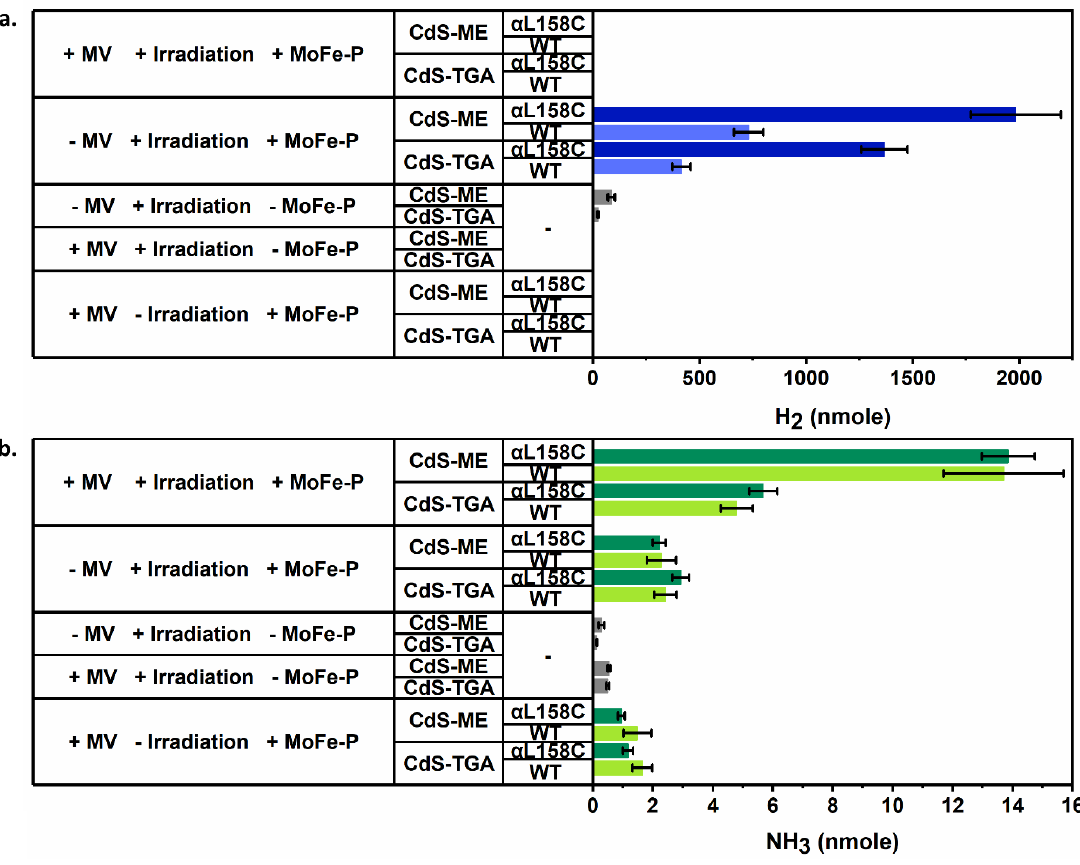
Figure 3. ( a ) H 2 and ( b ) NH 3 production of mediated and non-mediated CdS–ME / TGA NPs: MoFe-P biohybrid systems in 0.1 M PB pH 7.2 and 51 mM AA after 2 h of irradiation.